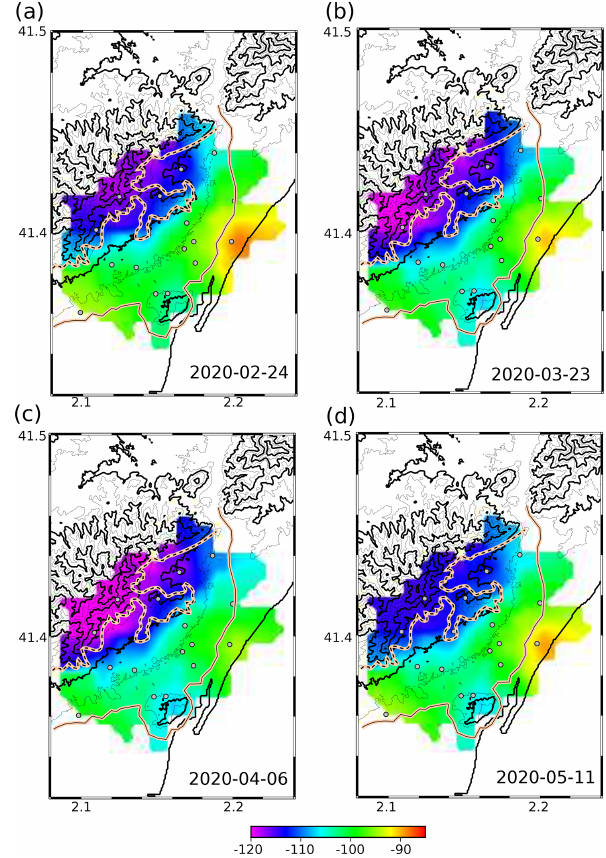
Figure 8. Daily maps representing the real power values in the 2– 20Hz band during working hours. Each image corresponds to a Monday (Fig. S4 shows all the daily snapshots). (a) Pre-lockdown period. (b) Lockdown phase 1. (c) Lockdown phase 2. (d) Lifting period. The dashed line marks the limit of the Paleozoic materi- als in the hills that surround Barcelona. The solid line marks the boundary between the areas covered by Holocene and Pleistocene materials (see Fig.